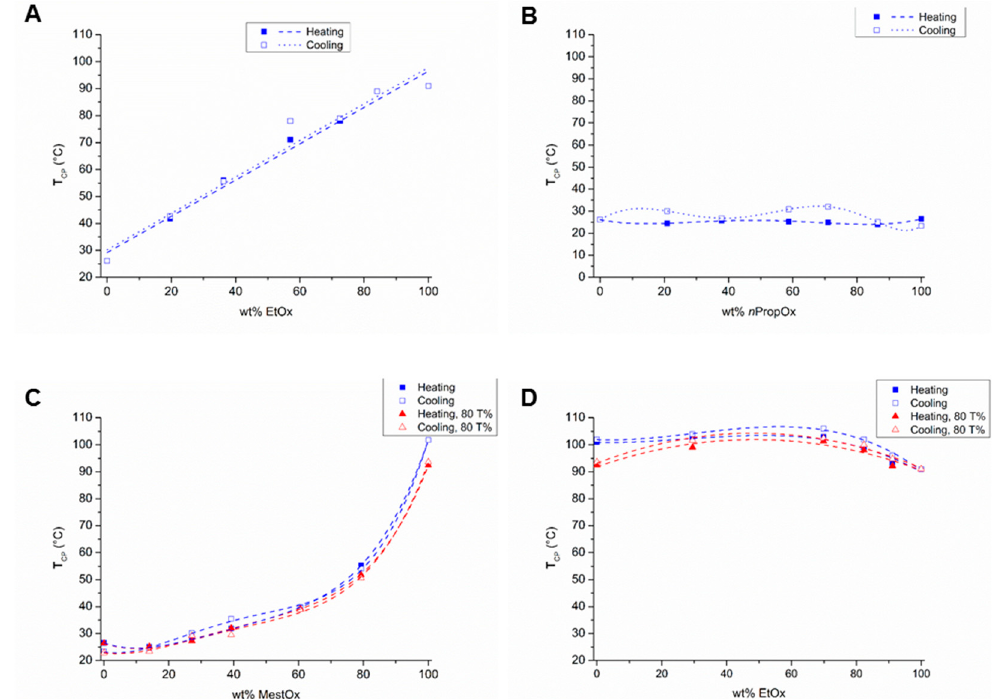
Figure 2. Cloud point temperatures (T CP ; determined at 50% transmittance unless otherwise stated) as a function of polymer composition of ( A ) P(EtOx–C3MestOx), ( B ) P( n PropOx-C3MestOx), ( C ) P( n PropOx–MestOx, and ( D ) P(EtOx–MestOx); lines are added to guide the eye. Copolymers of EtOx and MestOx displayed T CP s in between 93 °C and 103 °C at EtOx-MestOx comonomer ratios of 90:10, 80:20, 70:30, and 30:70 (Figure 2D, Table 1), whereas surprisingly the copolymer with a 50:50 comonomer ratio did not show a transition up to 110 °C. Additionally, here